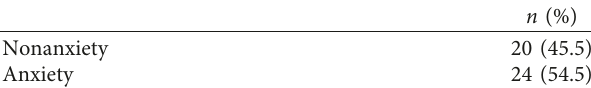
Table 2: Proportion of anxiety in patients undergoing